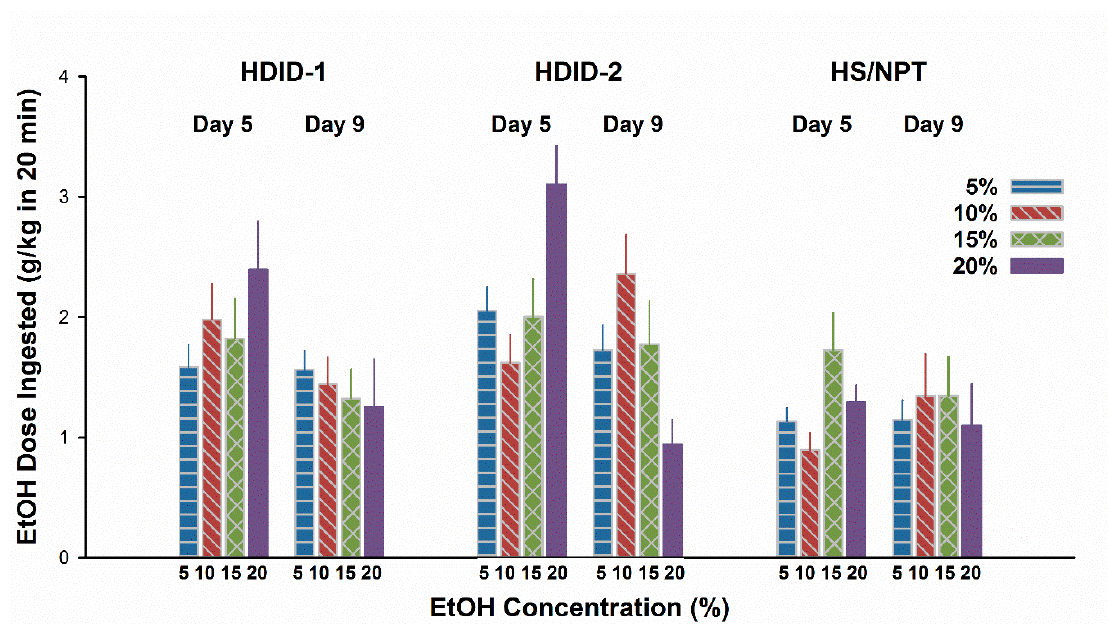
Figure 4. Concentration ‐ and genotype ‐ dependence of initial EtOH ingestion in HDID ‐ 1, HDID ‐ 2, and HS/NPT mice under conditions of fluid restriction. Mean ± SEM for groups of 16–20 mice per genotype and EtOH concentration.